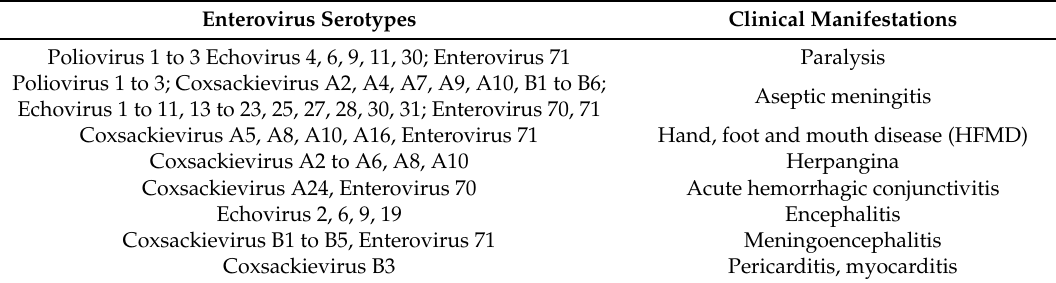
Table 1. Clinical manifestations of